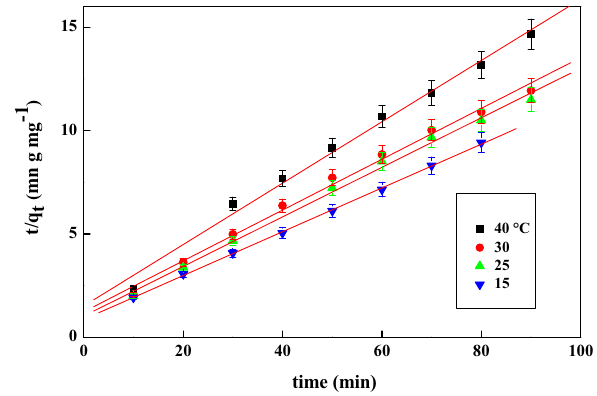
Table 4 Parameters for intra-particle diffusion model